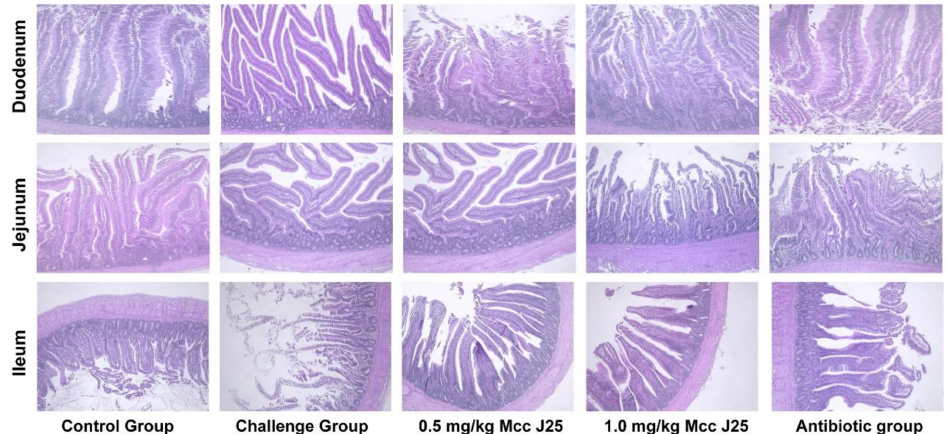
Figure 2. E ff ect of MccJ25 on intestinal mucosal morphology of duodenum, jejunum, and ileum in broilers. Scale bars, 100 µ